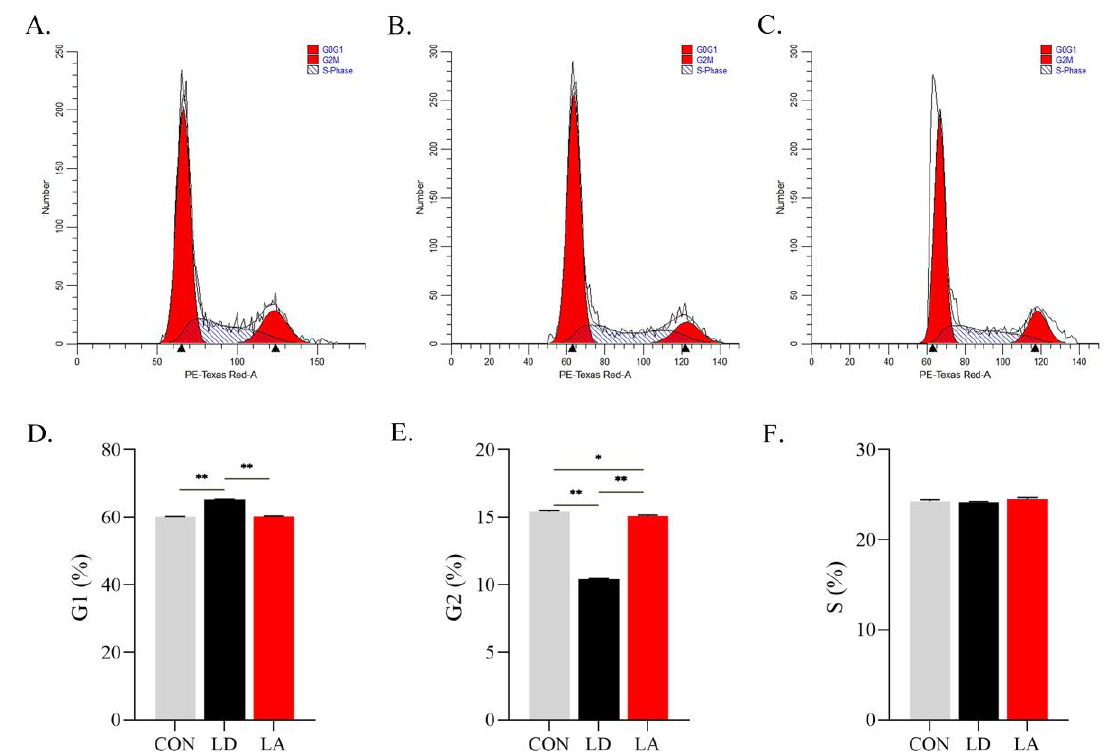
Figure 4. Lysine deficiency causes SCs cycle arrest. ( A ) CON; ( B ) LD; ( C ) LA; ( D ) G1 phase cell ratio (%); ( E ) G2 phase cell ratio (%); ( F ) S phase cell ratio (%). * p < 0.05, ** p < 0.01. The data shown represent mean ± SEM of three independent experiments ( n = 3).